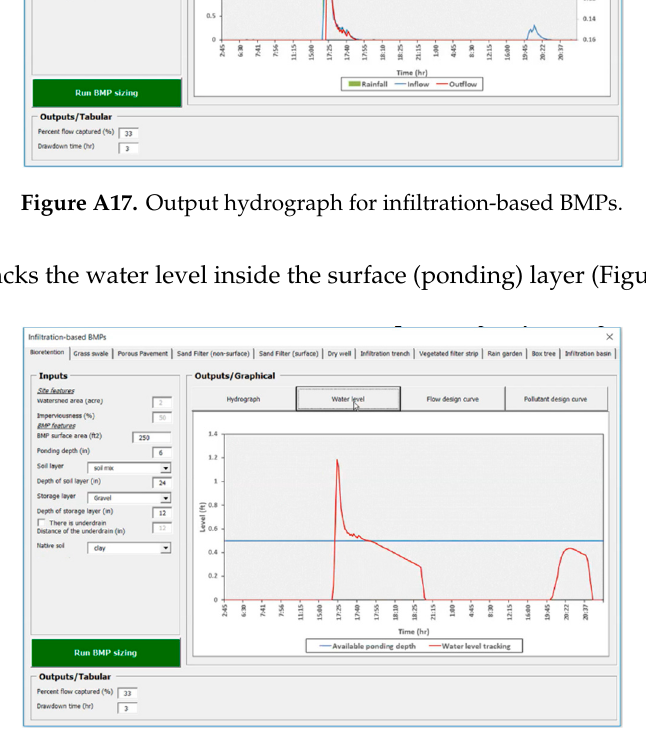
Figure A18. Water level tracking in infiltration-based BMPs